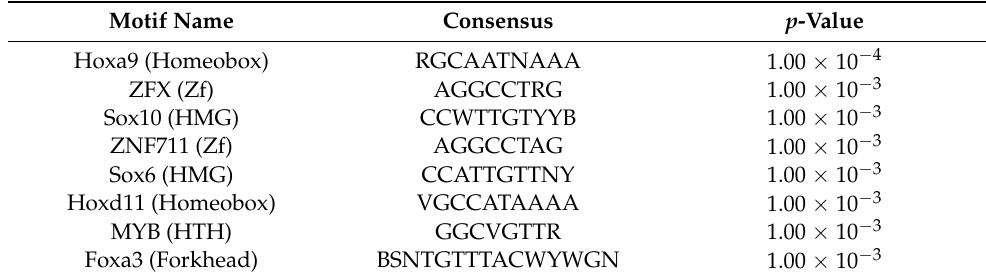
Table 4. Enriched transcription factor motifs in DMRs of MD patients compared to controls according to